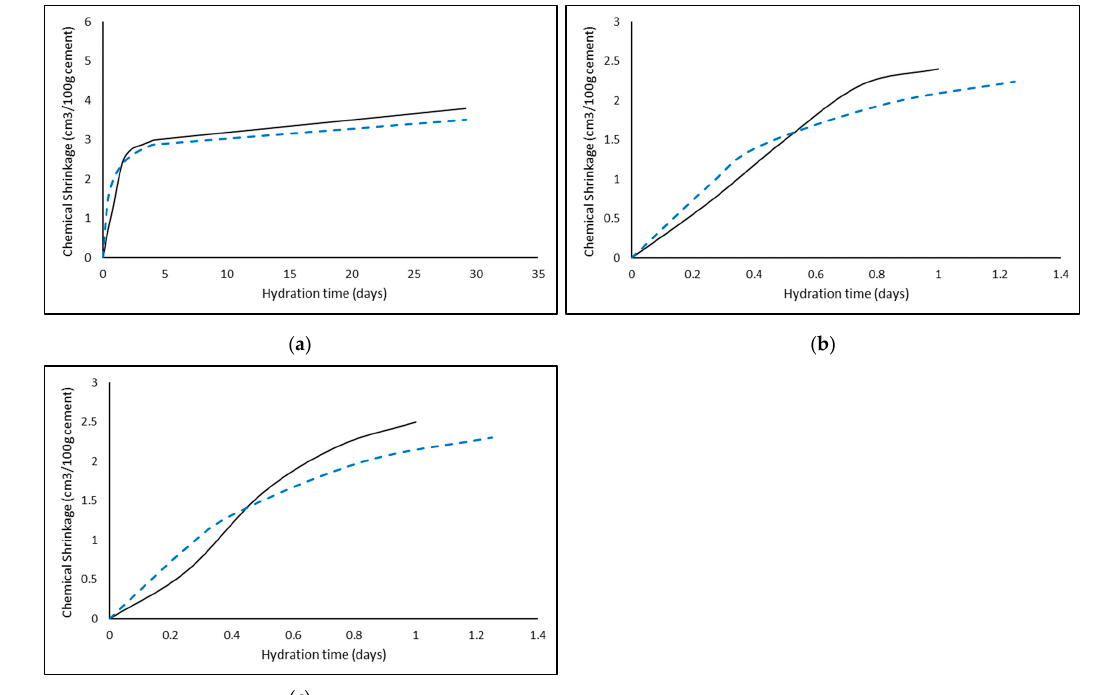
Figure 5. Comparison between predicted (dashed line) and measured (solid line) chemical shrink- age from ( a ) CEM I [8], ( b ) CEM I [1] and ( c ) CEM II [1] with a 0.4 w/c cement. from ( a ) CEM I [8], ( b ) CEM I [1] and ( c ) CEM II [1] with a 0.4 w/c